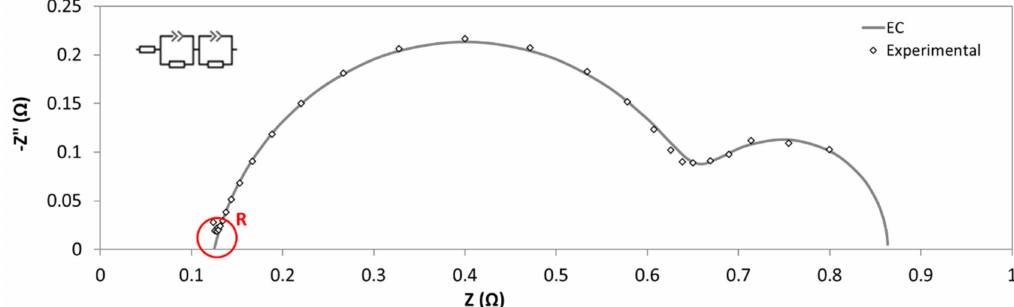
Figure 13. Nyquist diagram for determination of diaphragm resistance. Inlet: equivalent circuit used for determination of resistance